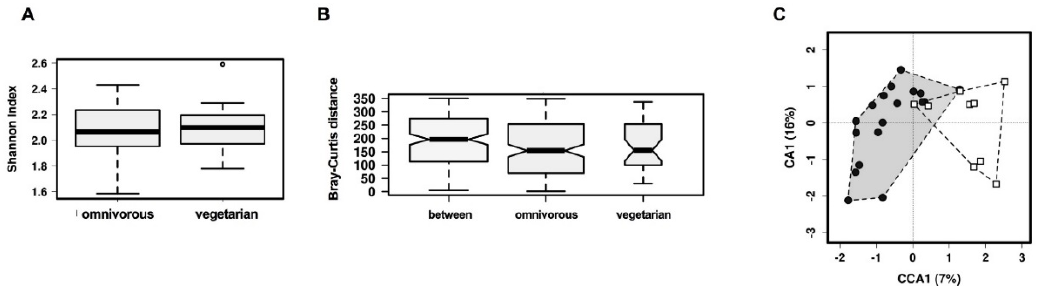
Figure 1. Measures of diversity, comparing vegetarian to omnivorous participants. ( A ) Shannon Index, Box plots show the 2.5th and 97.5th percentile with a line at the median; ( B ) Bray–Curtis Distance, Box plots show the 2.5th and 97.5th percentile with a line at the median; ( C ) Canonical correspondence analysis at the genus level according to diet. The percentage of variation is shown. ( p = 0.017). Black circles, omnivorous diet; white squares, vegetarian